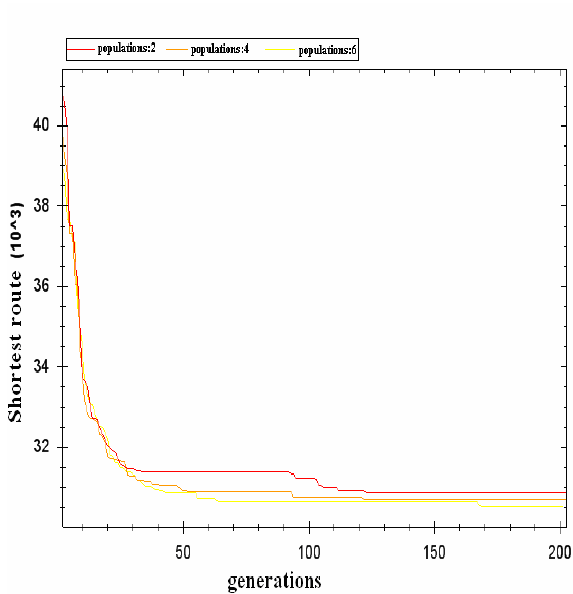
Figure13. The average result 5 of TSP benchmark instances Chn144 by different number of subpopulations